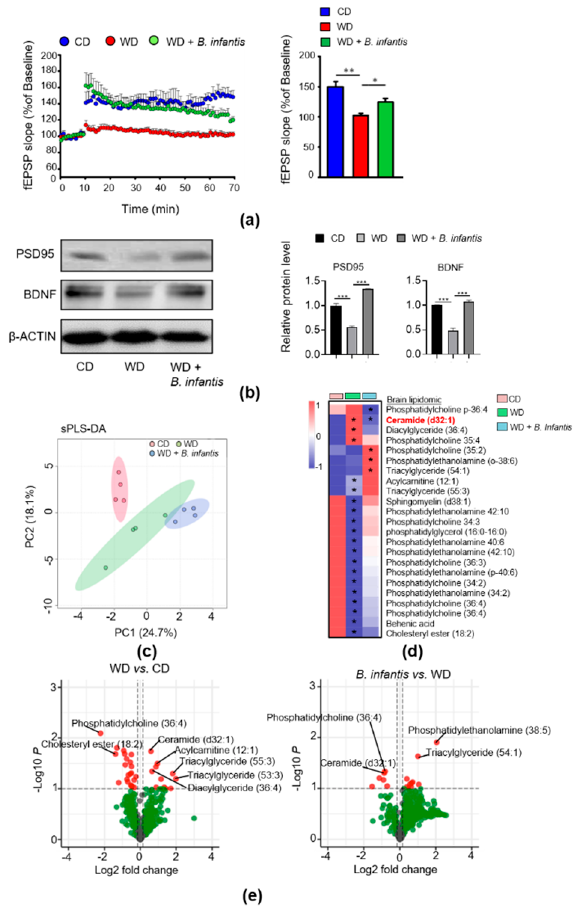
Figure 2. B. infantis treatment improved long-term potentiation (LTP) and synaptic deficits as well as an altered brain lipid profile: ( a ) Scatter plot indicates high-frequency stimulation-induced LTP, and the bar graph shows LTP calculated by averaging the change in fEPSP slope apparent between 50 and 60 min after high-frequency stimulation (n = 3, 9 slices per brain); all data is presented as the percent change in fEPSP slope means ± SEM from baseline; ( b ) Western blot data shows protein levels in the brains (CD, n = 6; WD, n = 6; WD + B. infantis , n = 4); ( c ) sPLS-DA based analysis of brain lipidomics; ( d ) Heatmap analysis shows a mean value of pick intensity of the top 23 lipids changed in each experimental group; ( e ) Volcano plots represent the brain lipidomics profile between WD vs. CD and WD + B. infantis vs. WD. The red color represents the fold changes of >2 with a p -value < 0.05, (n = 4). Data is mean ± SD. * p < 0.05, ** p < 0.01, *** p < 0.001.